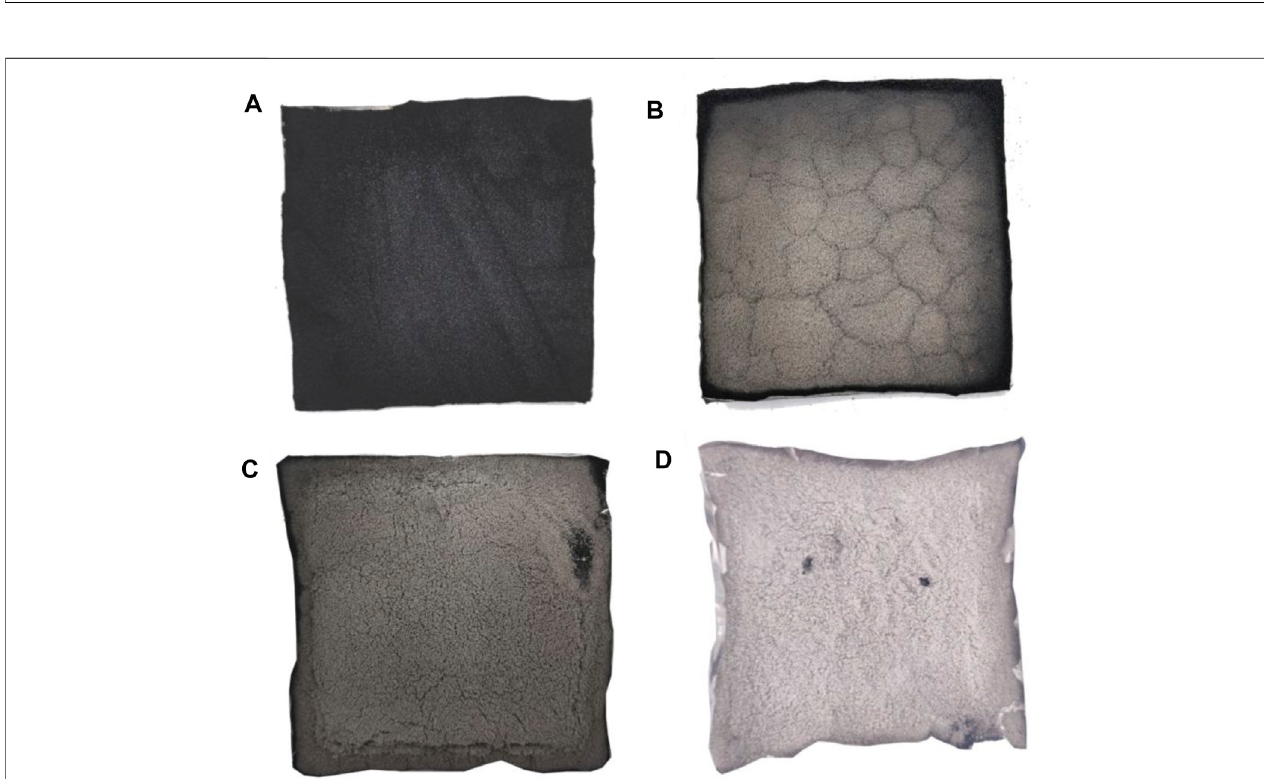
FIGURE 14 | Char residue photos of Bitumite: (A) HM15, (B) HM15, (C) HM35, and (D) HM50.